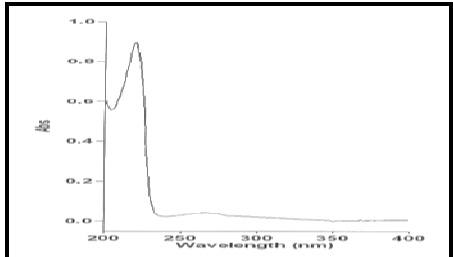
Figure (1) UV spectrum of BFN in 0.1 N